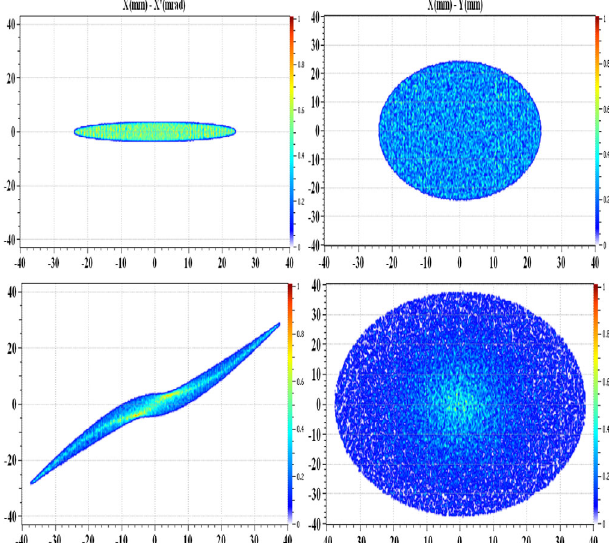
FIG. 2. Input beam distribution (top) and beam at the end of the drift (bottom) after experimenting the SCC for an H − beam at 30 mA.